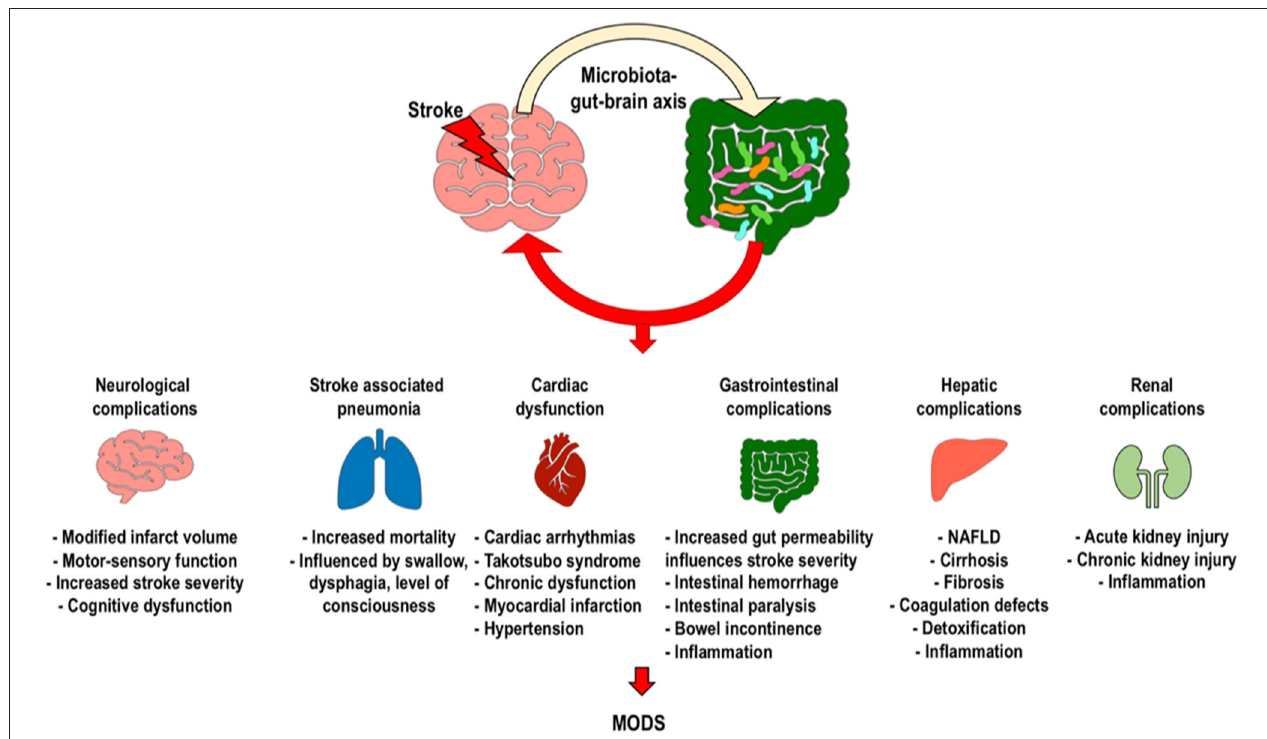
FIGURE 3 | Clinical implications of intestinal dysbiosis after ischemic stroke. Changes caused by stroke on the gut microbiota can induce neurological complications, stroke-associated pneumonia, cardiac dysfunction, gastrointestinal complications, and renal dysfunction, with possible development of the systemic inflammatory response and multiple organ dysfunction syndromes. [MODS, multiple organ dysfunction